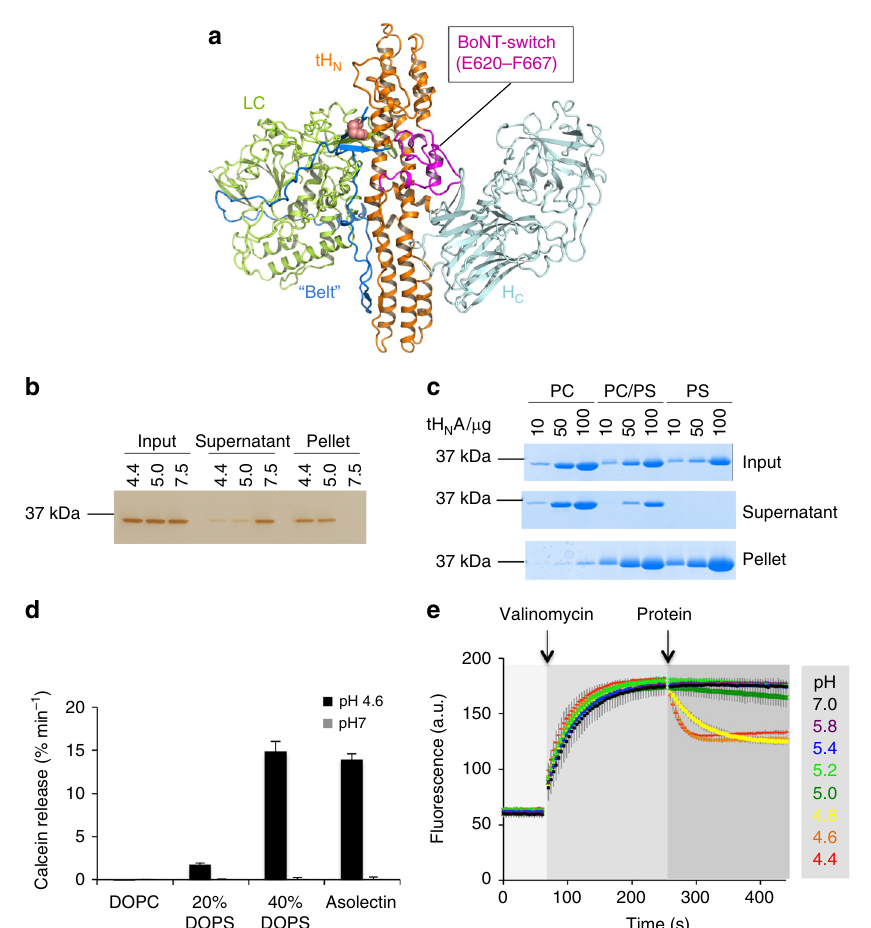
Fig. 1 Biochemical characterization of tH N A. a The structure of BoNT/A1 (PDB code 3BTA). LC, the “ belt ” , tH N , and H C are colored green, marine, orange, and cyan, respectively. The disul fi de linkage between LC and H N is shown as salmon sphere and the BoNT-switch is highlighted in magenta. b , c Co- sedimentation of tH N A with liposomes. tH N A was incubated with asolectin liposomes at pH 7.5, 5.0 or 4.4 ( b ); or incubated with liposomes containing 60/40 mol% PC/cholesterol, 30/30/40 mol% PC/PS/cholesterol, or 60/40 mol% PS/cholesterol at pH 4.4 ( c ). After liposomes were pelleted, the proteins in input, supernatant, and pellet fractions were analyzed by SDS-PAGE. These experiments were performed in triplicate and quanti fi cation of protein band intensities are shown in Supplementary Fig. 11. Uncropped images of gels are shown in Supplementary Fig. 13. d Calcein dye release assay. tH N A was tested with four different liposomes loaded with 50 mM calcein at pH 4.6 or pH 7.0, whereas liposomes were composed of DOPC alone, 80/20 mol% DOPC/DOPS, 60/40 mol% DOPC/DOPS, or asolectin. The rate of calcein dye release was determined based on the increase of fl uorescence at 525 nm during excitation at 493 nm. Error bars indicate SD of triplicate measurements. e Membrane depolarization assay. Liposomes composed of 70/20/10mol% DOPC/DOPS/cholesterol were polarized at a positive internal voltage by adding valinomycin in the presence of a transmembrane KCl gradient. Membrane potential was measured using the voltage-sensitive fl uorescence dye ANS. After 3 min, tH N A was added at the indicated buffer pH. The data are presented as mean ± S.D., n =